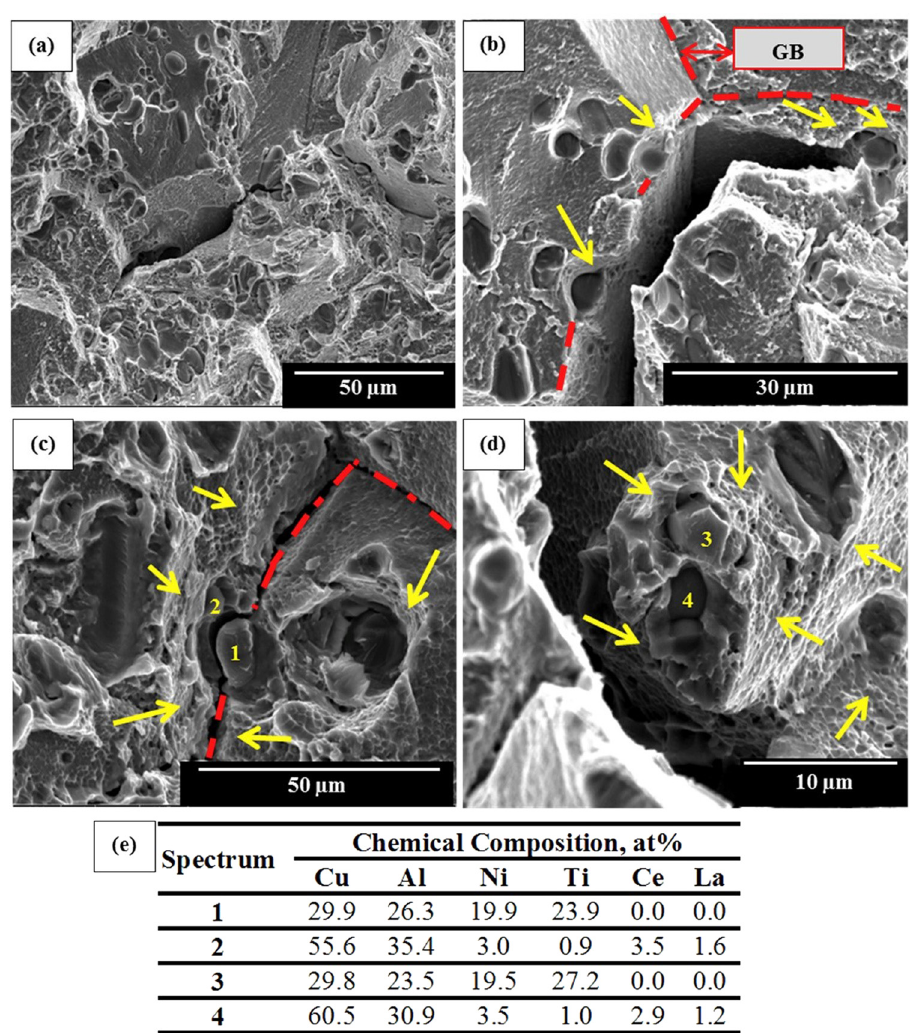
Figure 8: ( a – d ) SEM images of tensile fracture of Cu – 12Al – 3Ni – 0.6 Ti – Re alloy and ( e ) EDS microscopic analysis results of fractured numbering points [ 95 ]